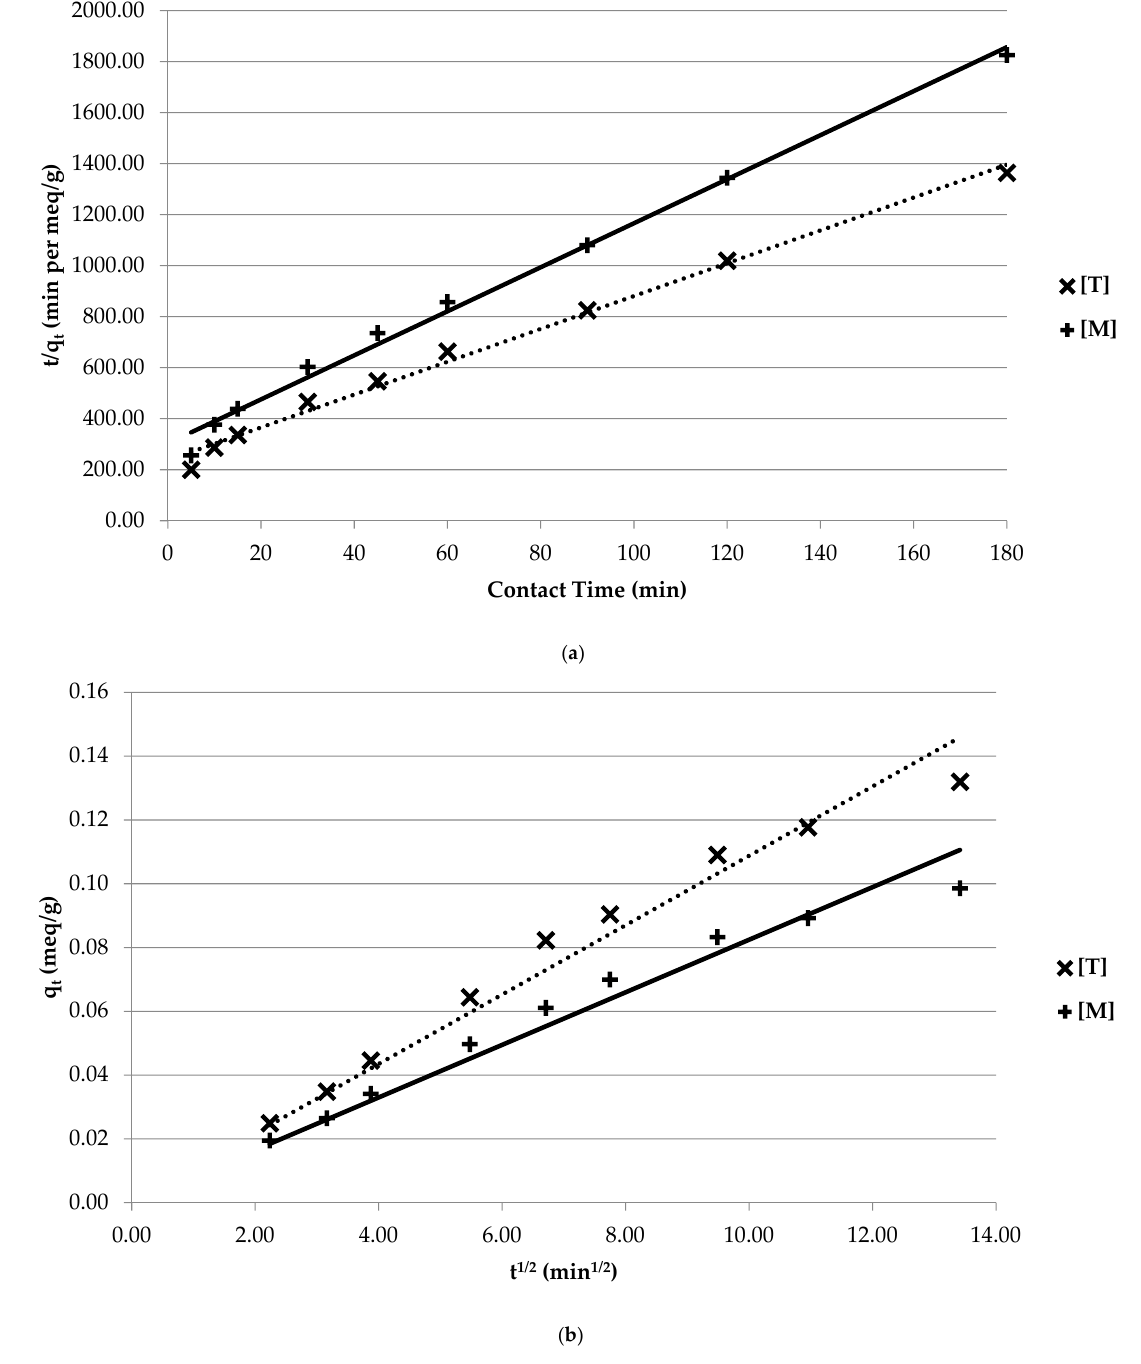
Figure 4. Triple ‐ and multi ‐ component system kinetic model plots: ( a ) pseudo ‐ second ‐ order; ( b ) intra ‐ particle diffusion.